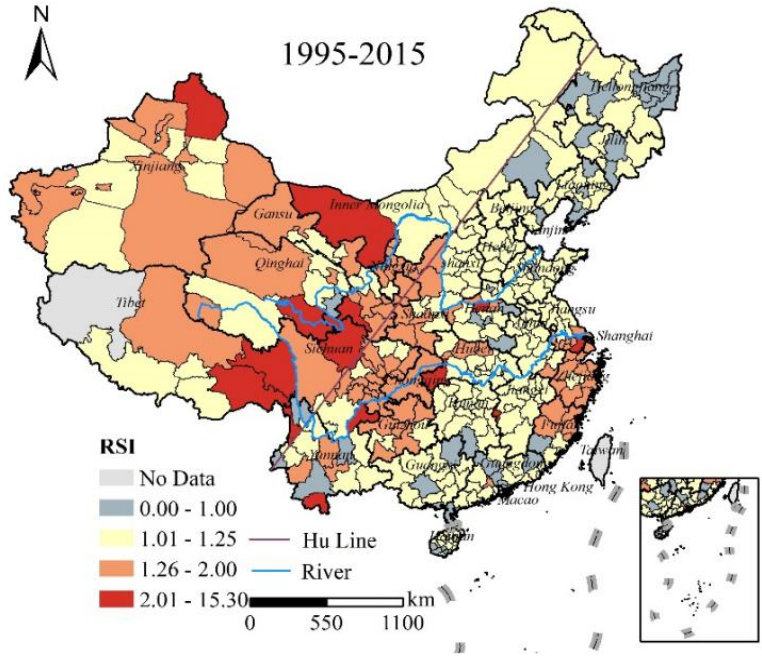
Figure 1. Rural settlement sprawl index values in China 1995–2015.